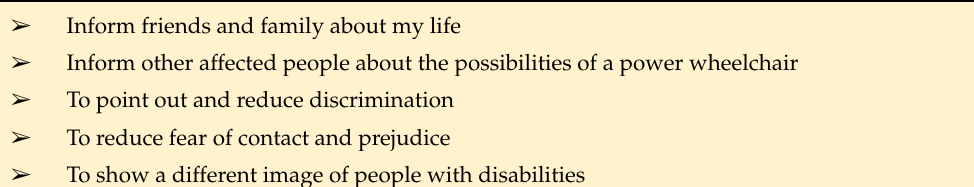
Table 1. Collective Research